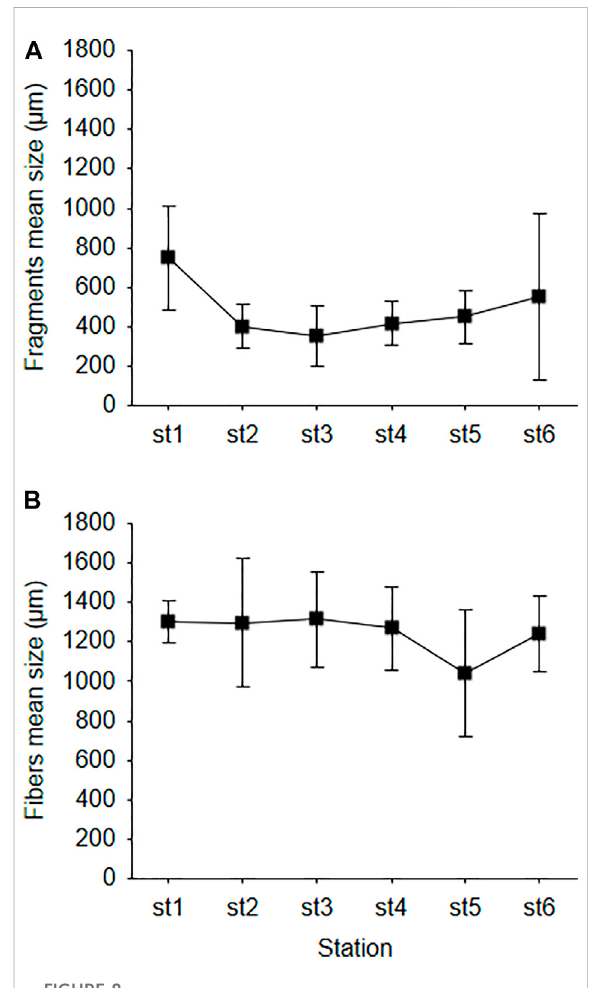
FIGURE 8 Spatial variation of fragments (µm; mean ± SD) (A) and fi bers (µm; mean ± SD) (B) mean